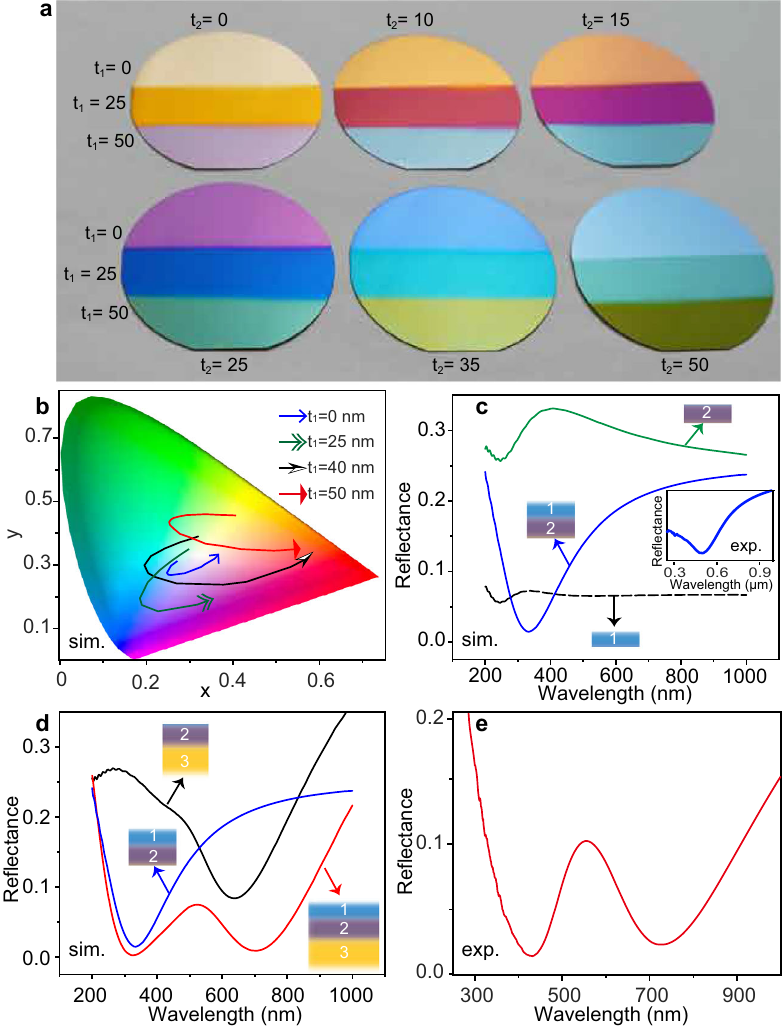
thicknessofeachcoatingis40nm.Inset:measuredre fl ectancespectrumof 40nm AlNcoatingon40nmTiAlN. d Simulatedre fl